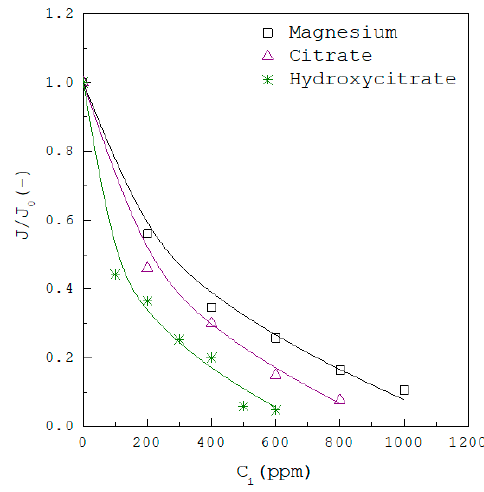
Figure 4. The decrease of J J 0 with increasing inhibitor concentration for the solutions in the presence of magnesium, citrate and hydroxycitrate for 𝑆 = 13.65 at 37 °C. Solid lines are visual guides.